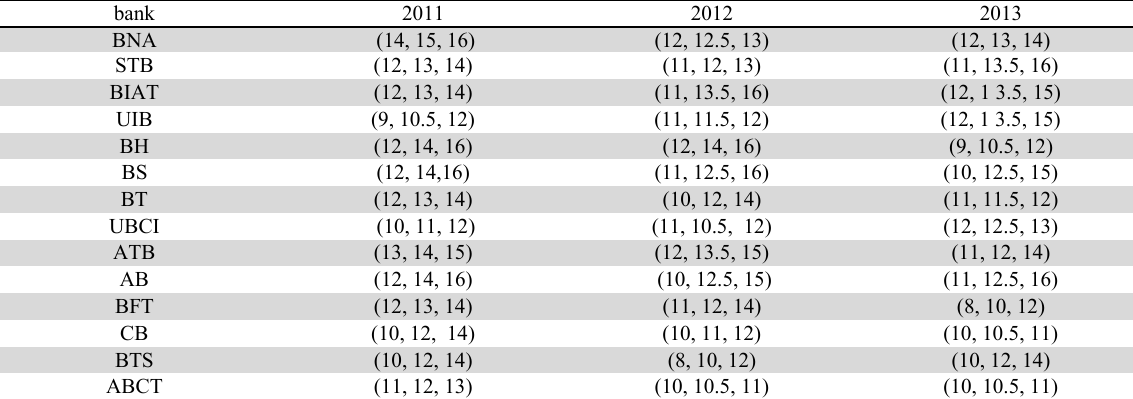
The results of the innovation level